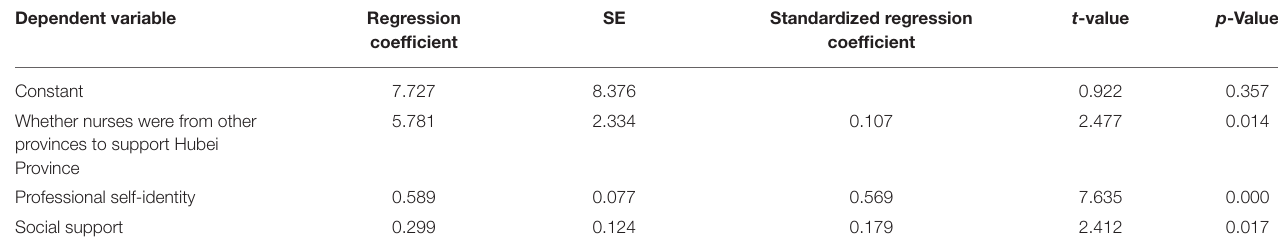
TABLE 4 | Multiple-factor analysis of PTG on nurses (x ± s, N =